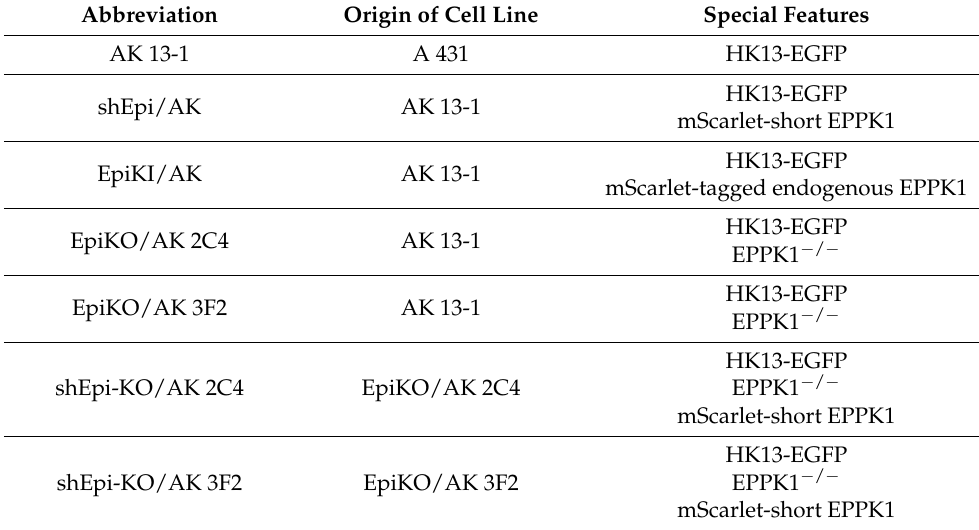
Table 1. Cell lines used and generated in this